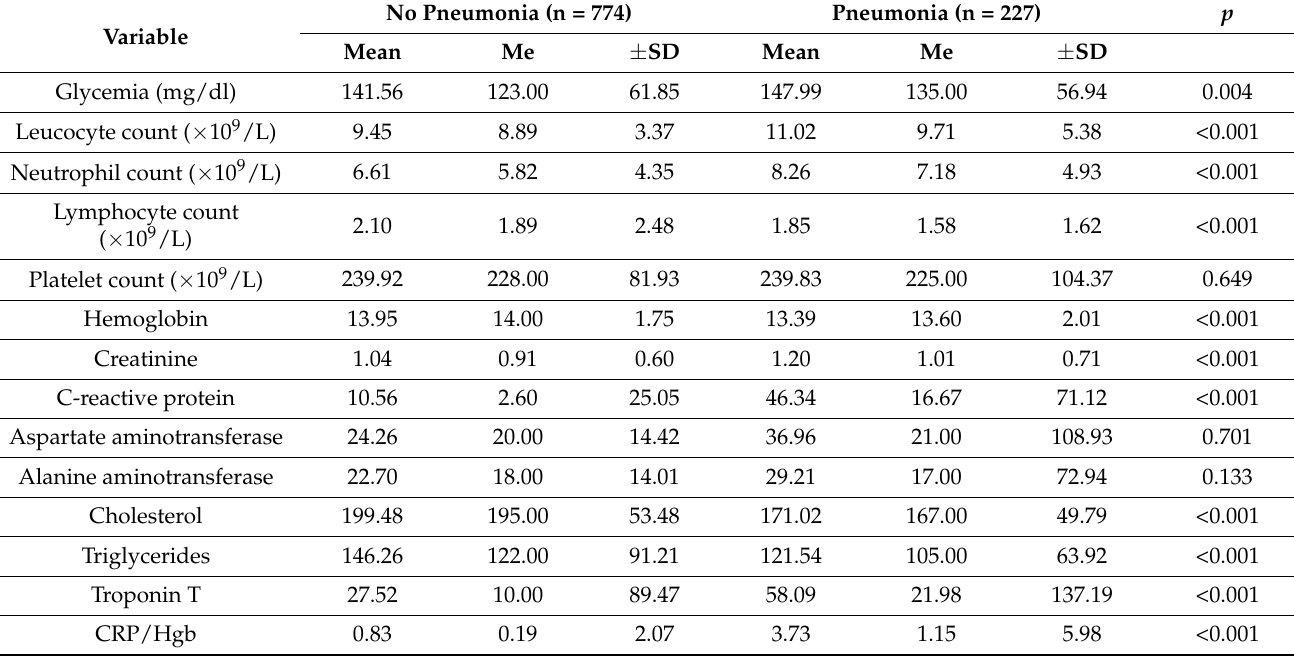
Table 2. Laboratory data for the admitted ischemic stroke